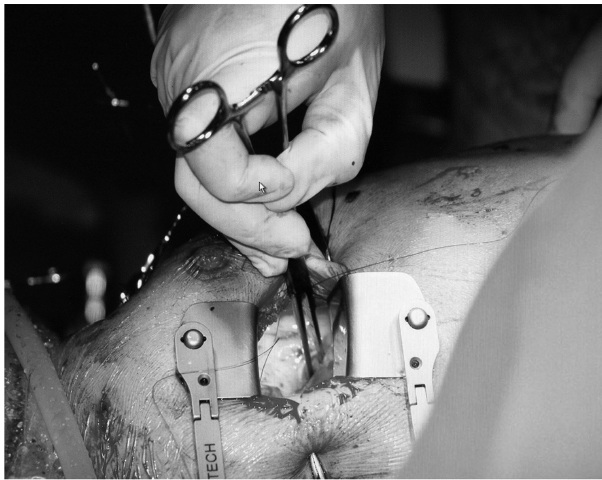
Fig. 1 - Retractor developed specifically for this type of operation introduced into the left